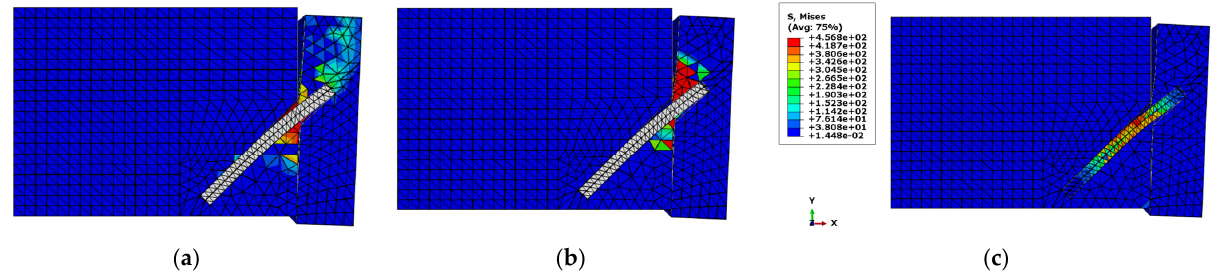
Figure 18. Damage of tension ( a ), of compression ( b ), and Mises stresses ( c ) on the nail for 45°.